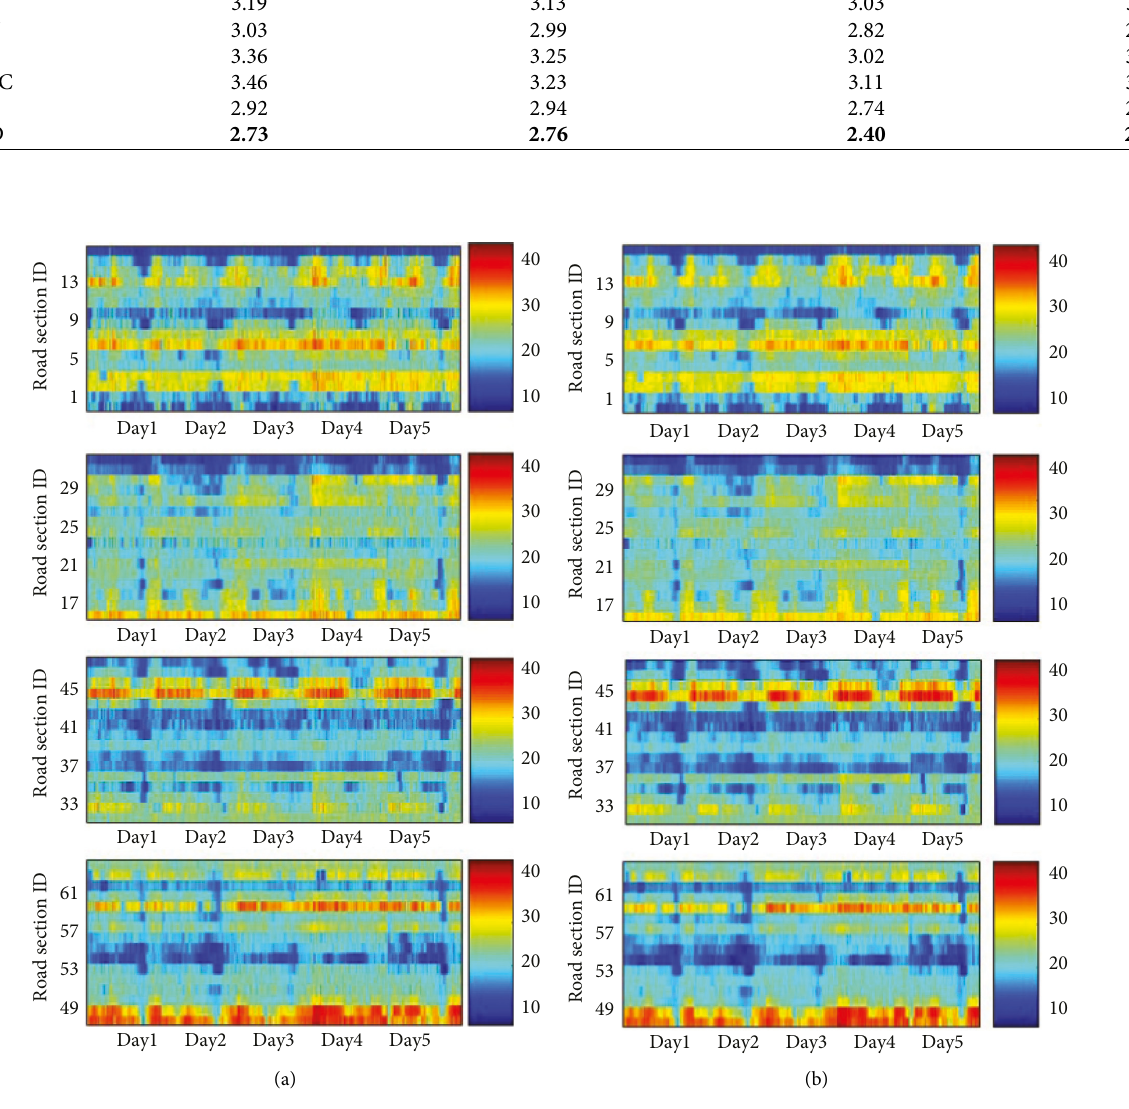
Figure 13: Comparison between the ground-truth and estimated data during the 5days. (a) Ground-truth data; (b) estimated data.